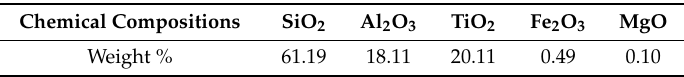
Table 2. Chemical composition of HNTs.